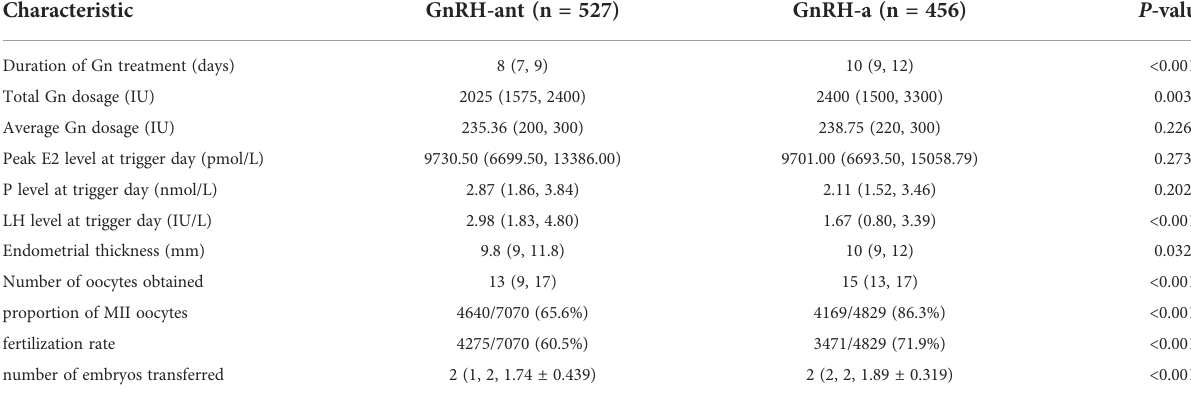
TABLE 2 Stimulation characteristics for each ovarian stimulation